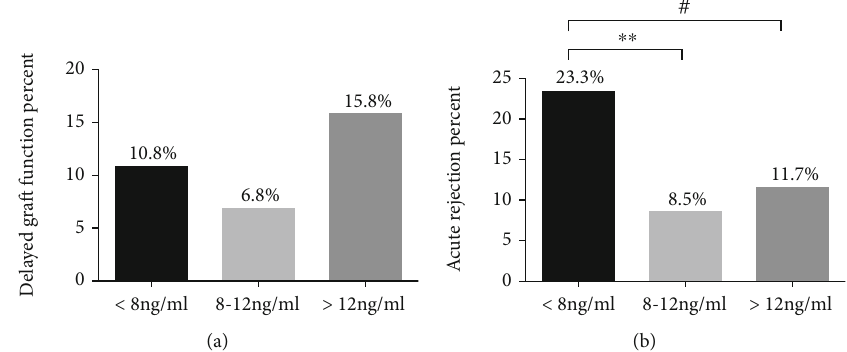
Figure 3: Associations among early tacrolimus concentration, delayed graft function (DGF), and acute rejection (AR). The average tacrolimus concentration was classi fi ed as follows: < 8 ng/mL; 8 – 12 ng/mL; and > 12 ng/mL. (a) Incidence rate of DGF by tacrolimus concentration. (b) Incidence rate of AR by tacrolimus concentration. ∗∗ p < 0 : 01 for tacrolimusconcentration < 8 ng/mL VS . 8 ng/mL < tacrolimusconcentration < 12 ng/mL . # p < 0 : 05 for tacrolimusconcentration < 8ng/mL VS . tacrolimusconcentration > 12ng/mL